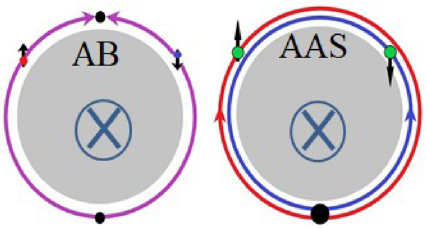
Figure 2. The cartoon of AB and AAS oscillations. Carriers travel half loops and form quantum interference at the other side of the loop in the AB oscillation. Carriers travel a whole loop and form quantum interference at the original position in the AAS oscillation.